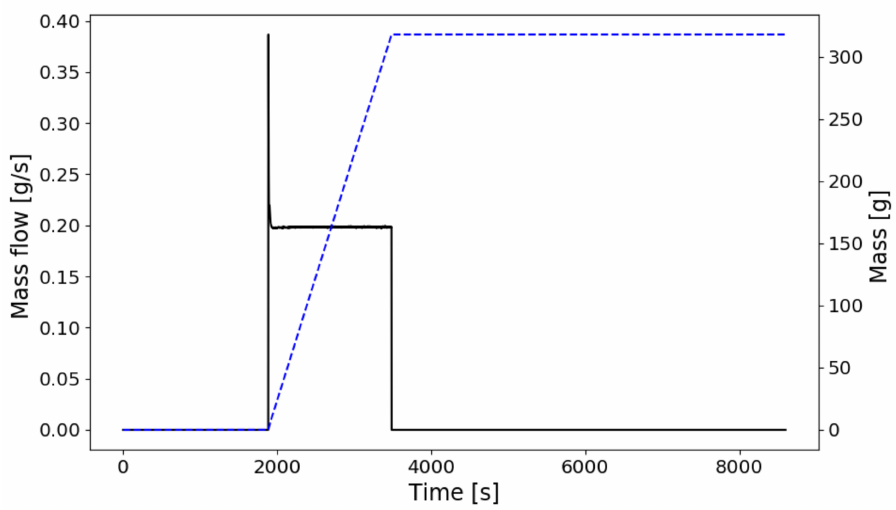
Figure 13. Injection rate and integrated mass of hydrogen during SSP3